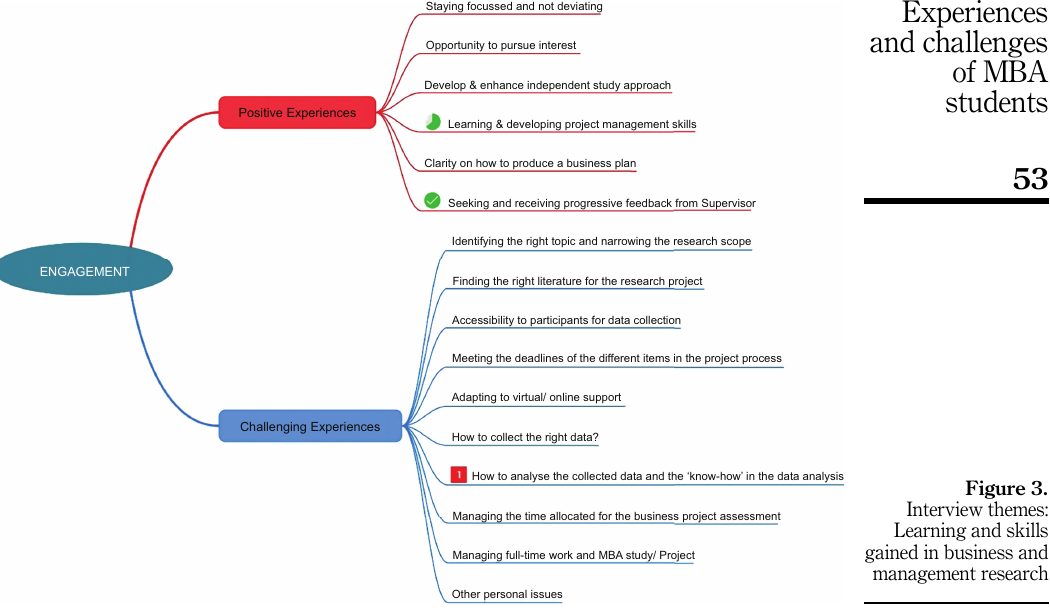
Figure 3. Interview themes: Learning and skills gained in business and management research